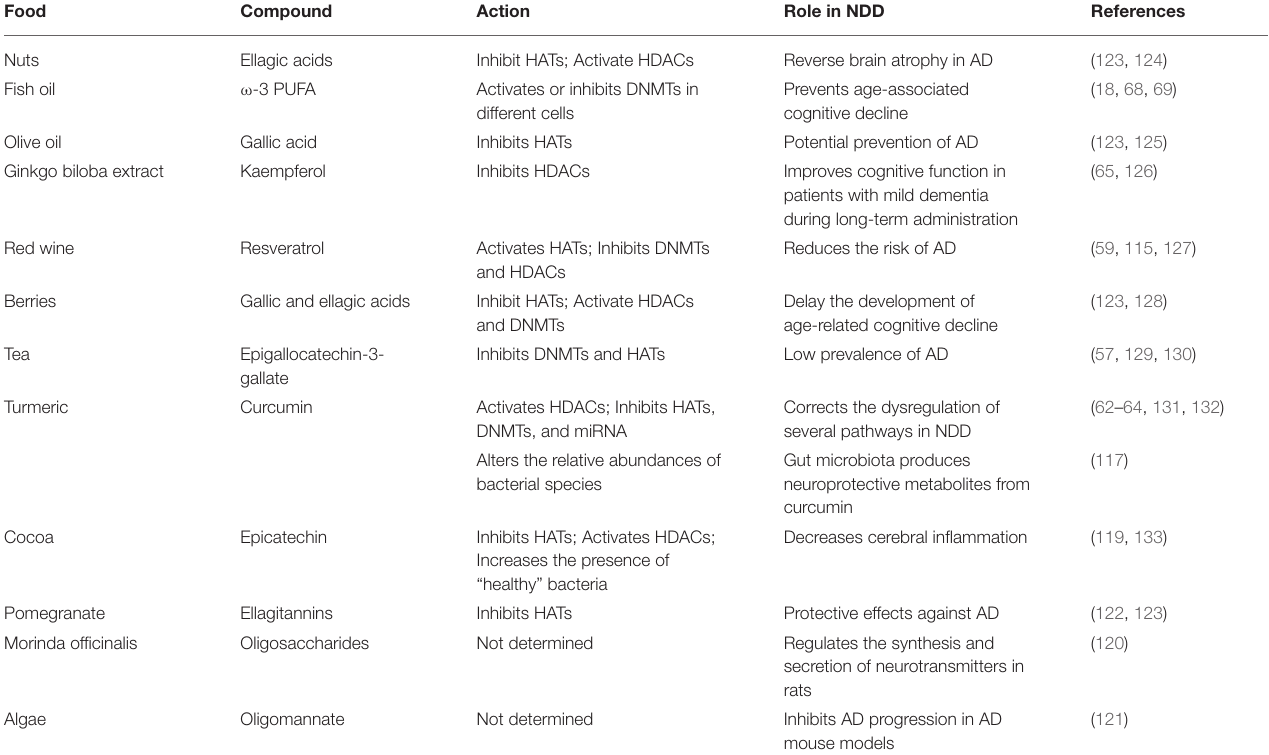
TABLE 1 | Bioactive compounds from food with effects on